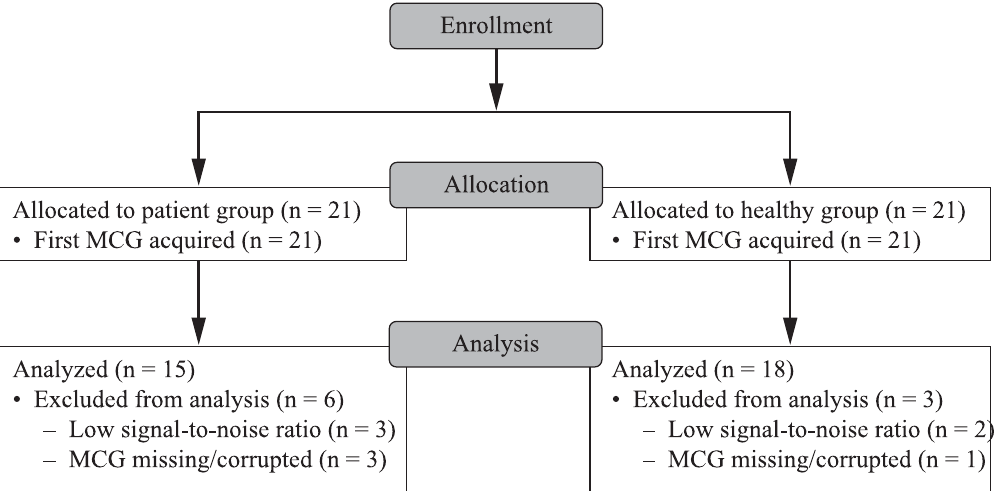
Fig 2. CONSORT Diagram: Pilot clinical study. Participant flow through the pilot clinical study. Data were analyzed for 15/ 21 patients and 18/21 healthy controls.